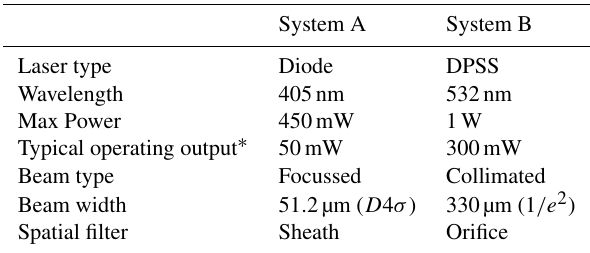
Table 1. Summary of the characteristics of the detection laser sys-